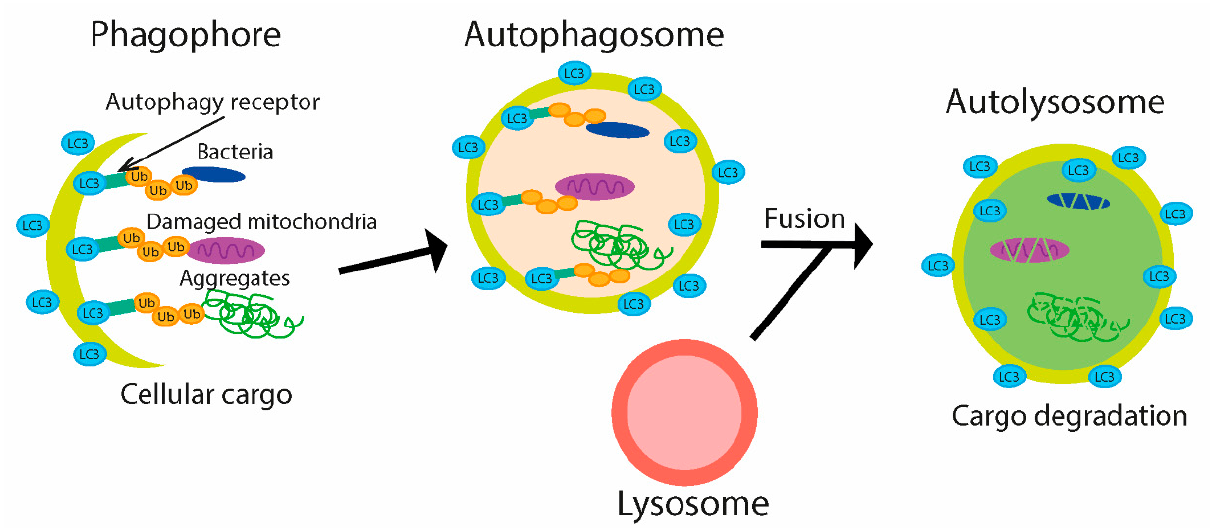
Figure 5. A cargo for selective ubiquitin-dependent autophagy, e.g., bacteria, aggregated protein or damaged mitochondria, is labeled by Ub chain. The cargo is recognized by autophagy receptors on the phagosomal membrane and subsequently maturation leading to the emergence of autophagosome occurs. The autolysosome is formed after fusion of autophagosome with lysosome, where the cargo is degraded. LC3—microtubule-associated protein 1 light chain 3, Ub—ubiquitin.